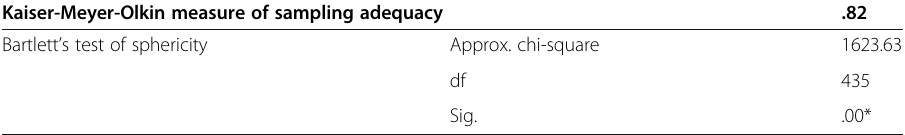
Table 2 KMO and Bartlett ’ s test Kaiser-Meyer-Olkin measure of sampling adequacy .82 Bartlett ’ s test of sphericity Approx. chi-square